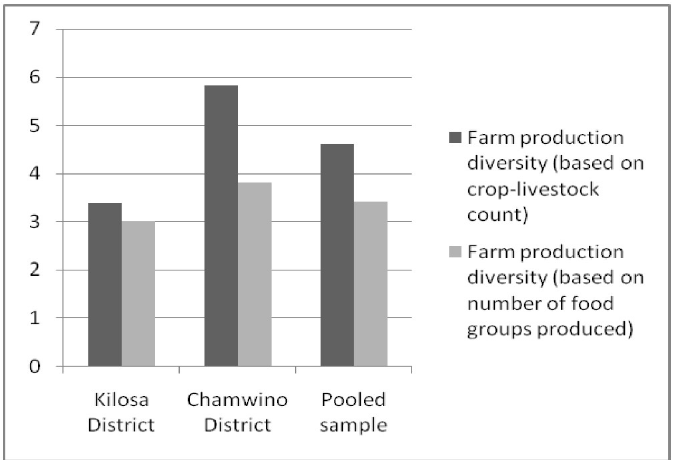
Figure 3. Comparison of mean farm production diversity by agro-ecology and market access in Kilosa and Chamwino Districts.